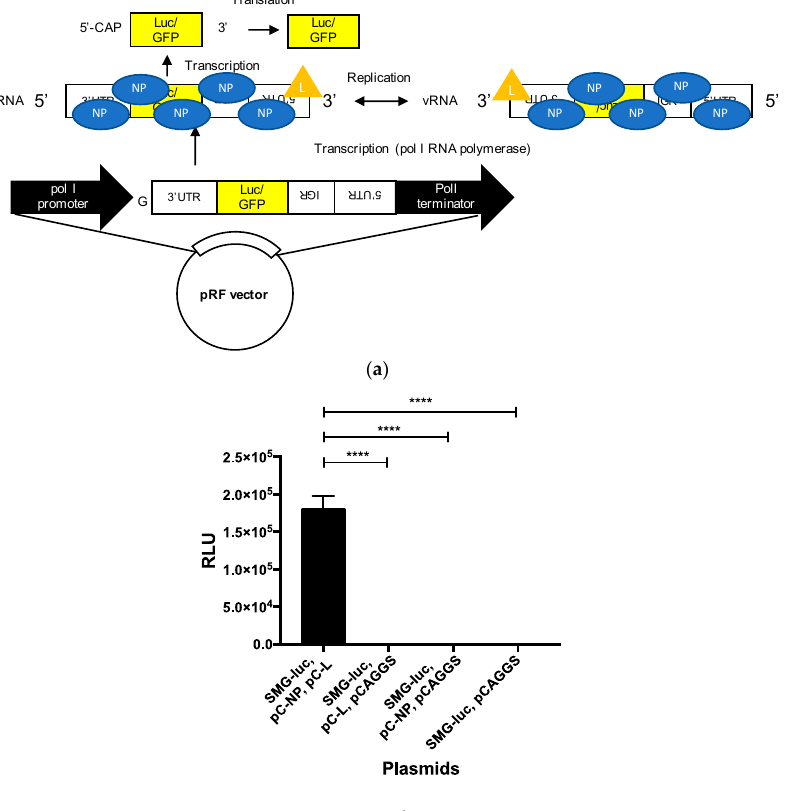
Figure 6. Establishment of a minigenome system for LCMV strain WE (LCMV-WE): ( a ) a schematic diagram of SMG-luc or -GFP and its replication, transcription, and translation processes. A cDNA fragment containing the S 5 (cid:48) UTR, S IGR, renilla luciferase, or GFP ORFs in an antisense orientation with respect to the 5 (cid:48) UTR and the S 3 (cid:48) UTR were cloned between the murine pol I promoter and the terminator of a pRF vector. An additional G residue was inserted between the murine pol I promoter and the viral genome sequence. The SMG plasmids are transcribed by the polymerase I RNA polymerase to generate cRNA in BHK cells. The cRNAs are then encapsidated with nucleoprotein (NP). vRNAs are produced in the presence of L protein (L). The encapsidated cRNA is transcribed into reporter gene mRNA. Finally, transcribed mRNA is translated by host-cell machinery to produce reporter proteins (luciferase or GFP). ( b ) BHK-21 cells were transfected with minigenome plasmids SMG-luc, either pC-NP or pCAGGS, either pC-L or pCAGGS, and pC-Fluc. The transfected cells were incubated for 2 days at 37 ◦ C, and then renilla luciferase activity was measured using the Renilla Luciferase Assay System and firefly luciferase activity was measured using the Bright-Glo Luciferase Assay System. (**** p < 0.0001) Error bars indicate standard deviations. The experiments were performed three times